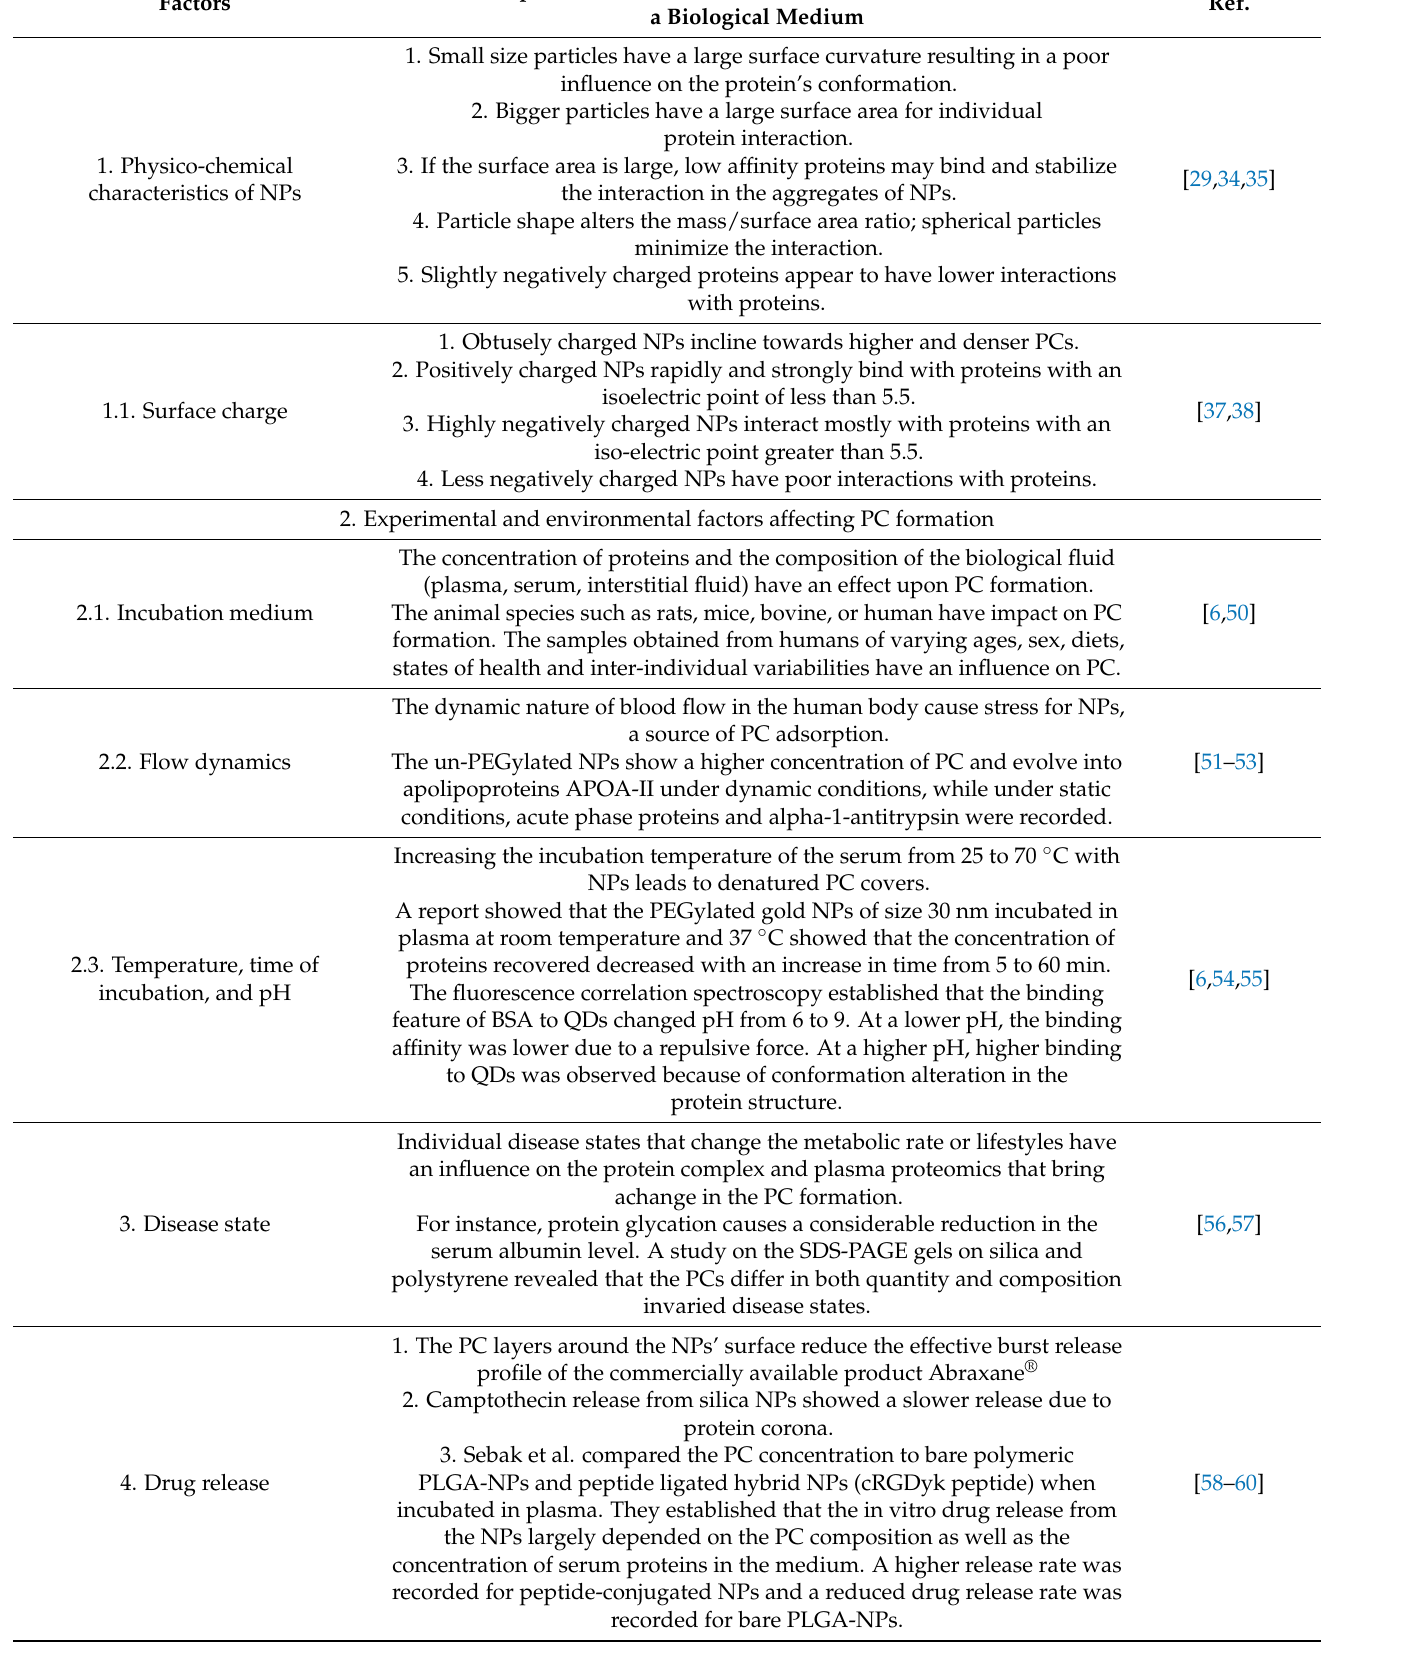
Table 1. Effect of the physico-chemical characteristics of nanomaterials in PC formation in the biological milieu. Impact on the Fate of NPs via Interaction with PC in Factors a Biological Medium